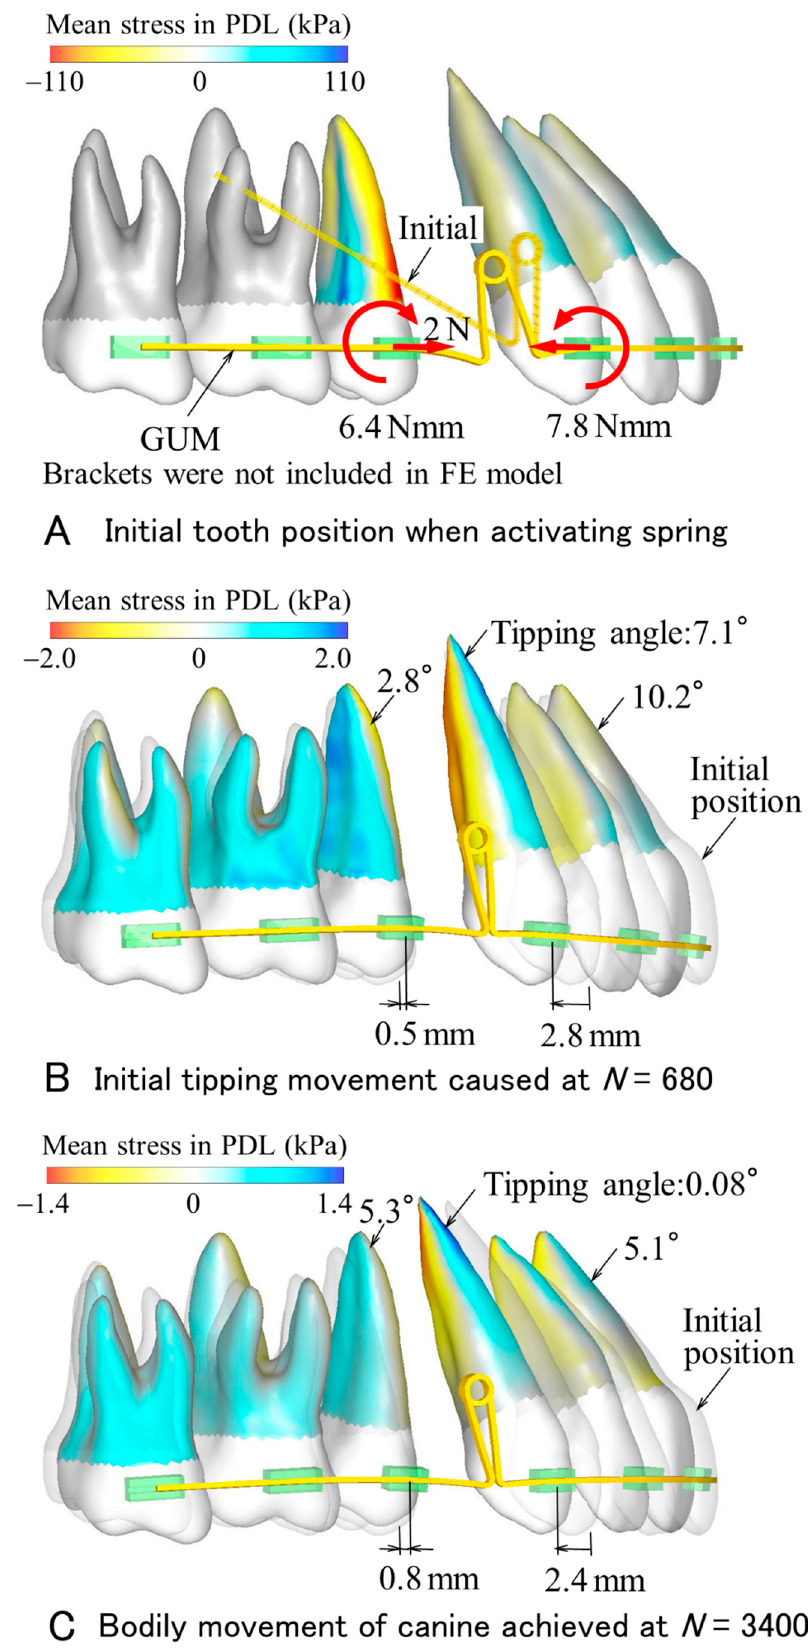
Figure 3. Tooth movement produced by GUM spring.